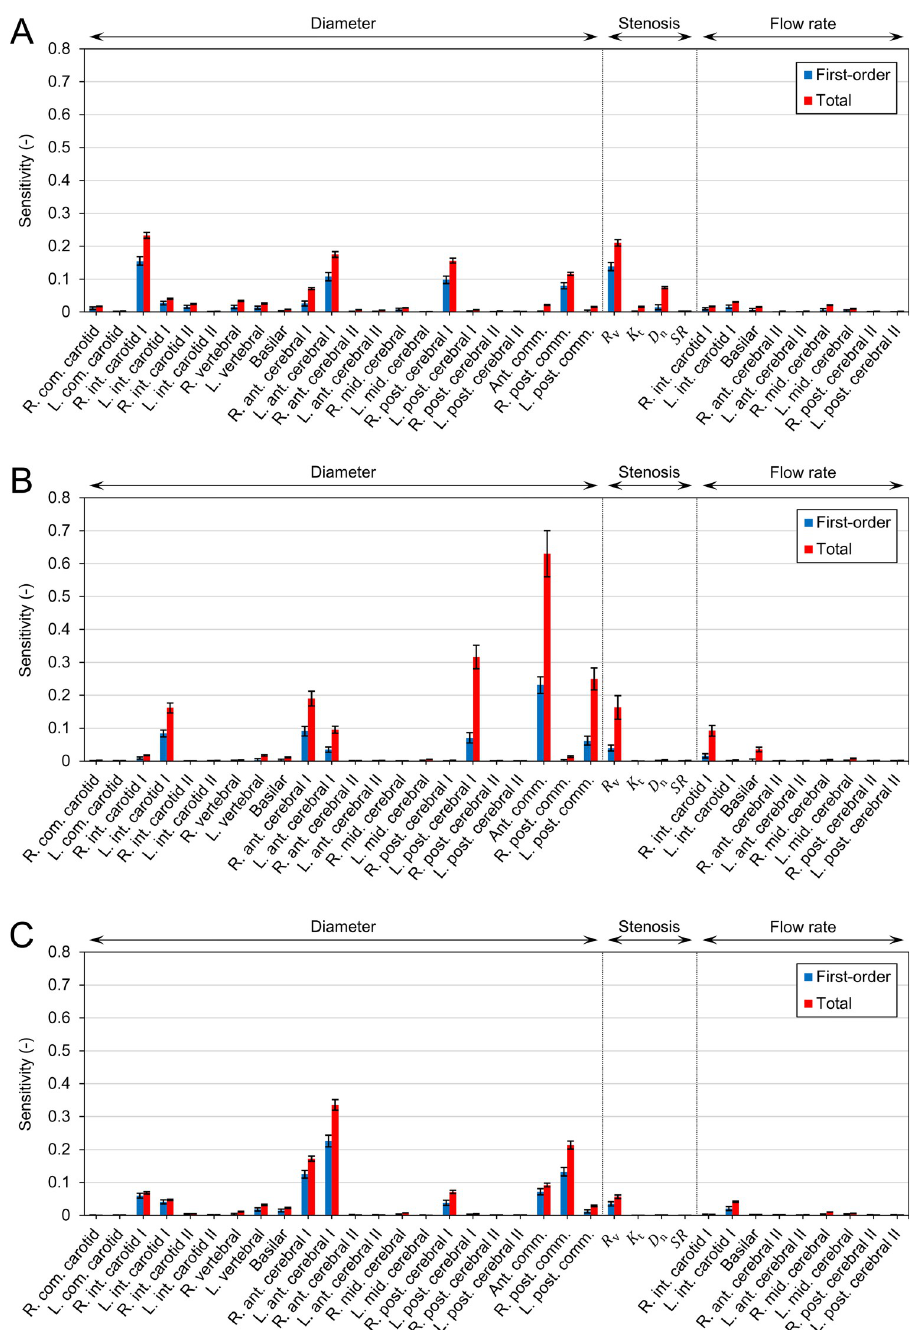
Fig 11. Sensitivities of uncertain parameters to the postoperative flow increase ( D � Q ). The first-order ( S n ) and total ) sensitivity indices are depicted as bars, and their 95% confidence intervals are represented by black lines. (A) ( S T, n Patient 1, (B) Patient 2, and (C) Patient